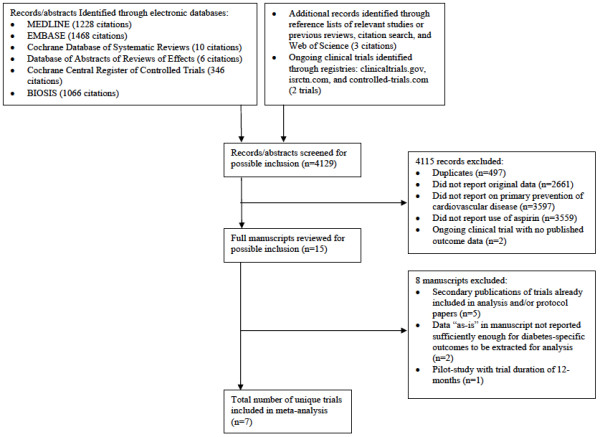
Study flow diagram.